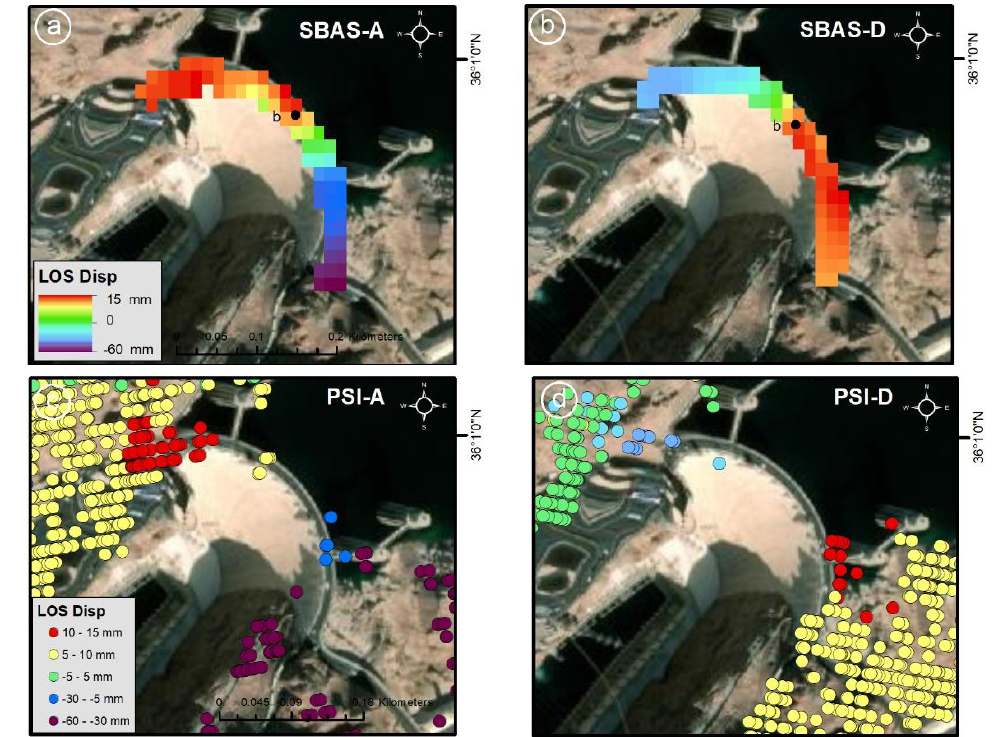
Figure 7. LOS displacements in Hoover Dam derived by the SBAS and PSI. ( a ) SBAS displacement along the LOS in ascending (SBAS−A), ( b ) and descending (SBAS−D) mode, ( c ) PSI displacement in ascending (PSI−A) and ( d ) descending (PSI−D) modes. Point “b” indicates the middle of the crest. In the middle of the crest of the dam (point b: Figure 7a), the SBAS and PSI time-series level, and as for the case of the reservoir’s surroundings during the S1 period, ground displacements were small (Figure 8 and Table 4).